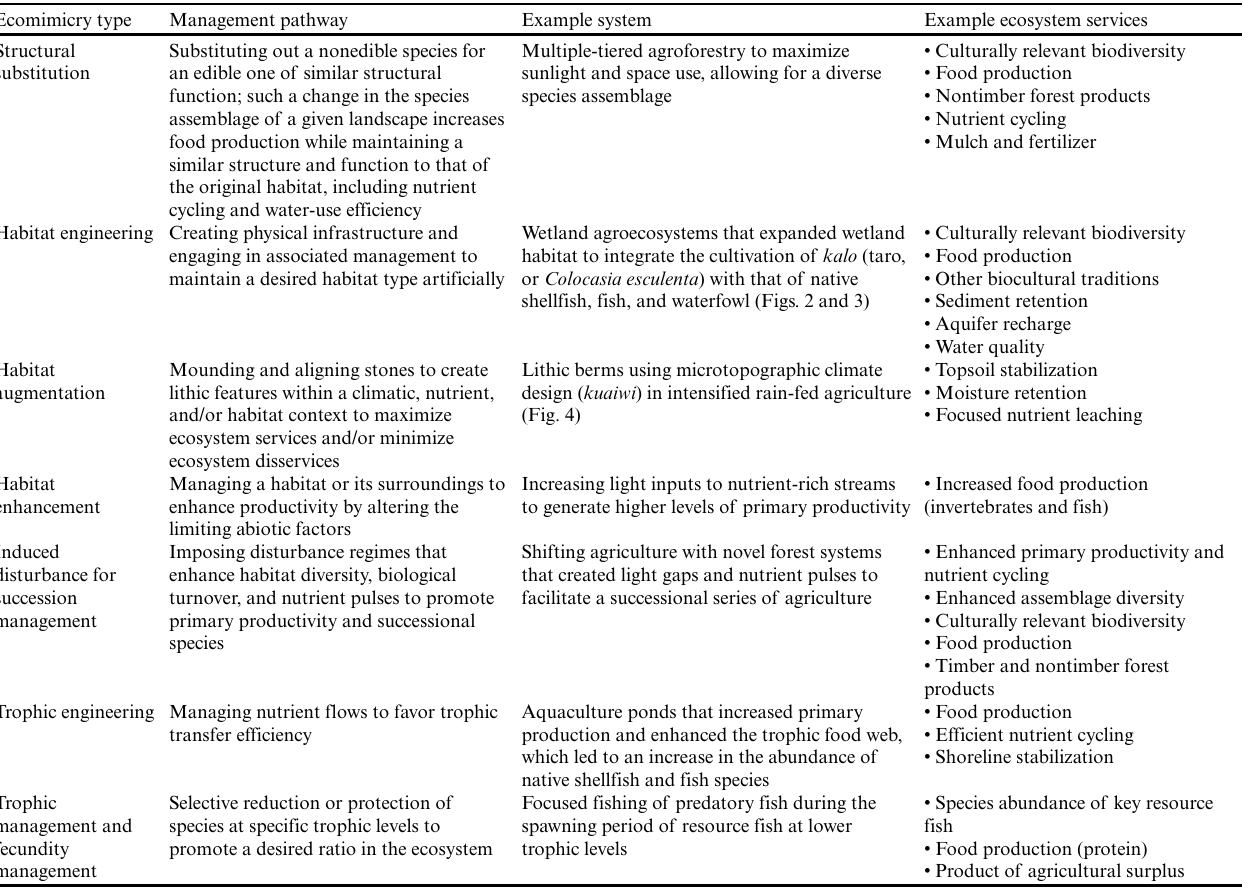
Table 1. Examples of various forms of ecomimicry integrated into the design of Hawaiian social-ecological systems in the precontact era, with descriptions of their management pathways and examples for each, along with a general list of associated ecosystem services. None of these forms persist today on a broad scale, but some forms are being revived on a local scale in remote pockets as the Hawaiian renaissance continues into its fourth